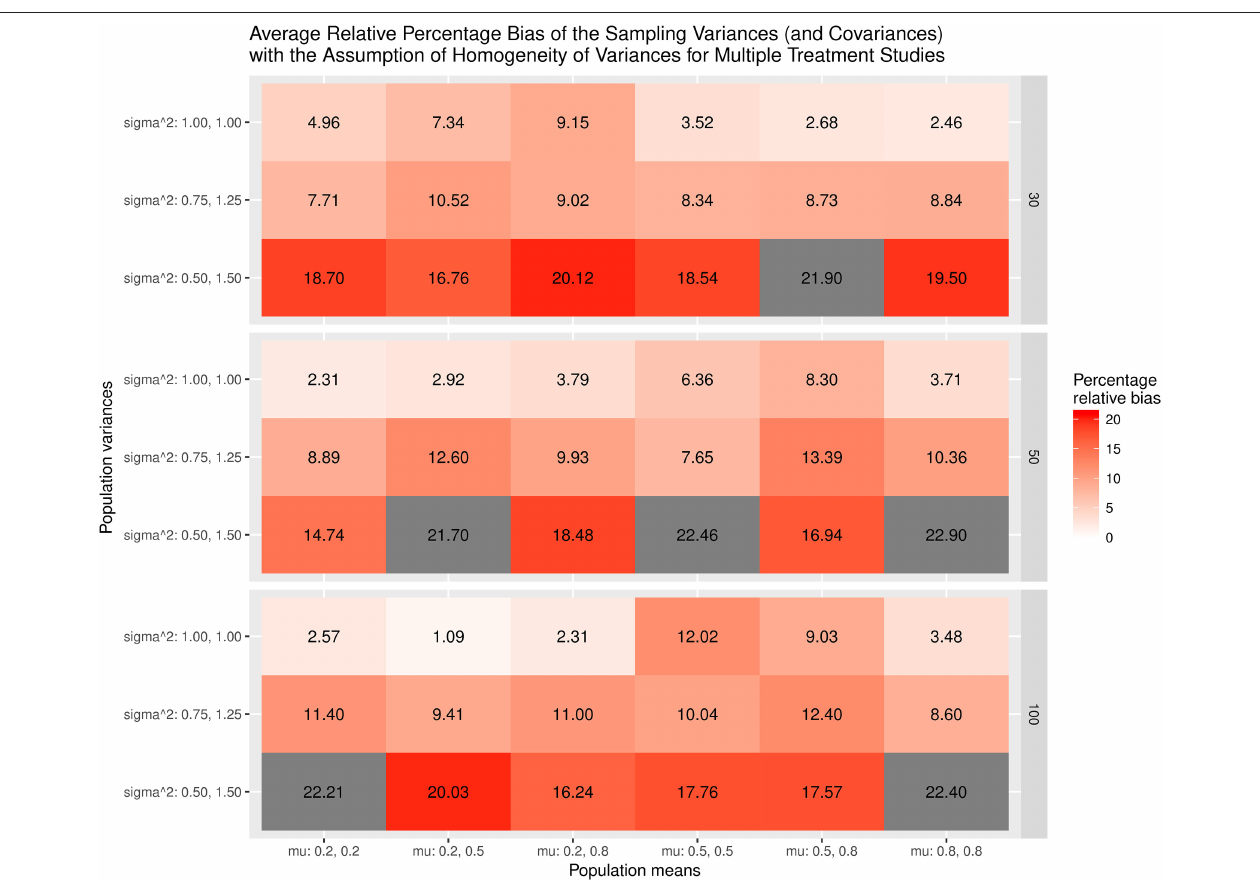
FIGURE 5 | Relative bias of the average of the sampling variances and covariance for the multiple treatment studies with the assumption of homogeneity of variances.